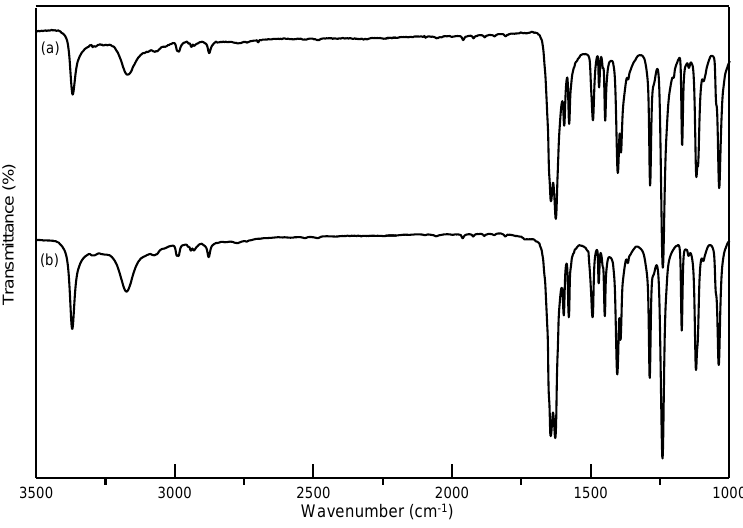
Figure 4. Differential scanning calorimeter (DSC) thermogram of ( a ) unprocessed ethenzamide and ( b ) RESS-processed ethenzamide from Experiment 12.